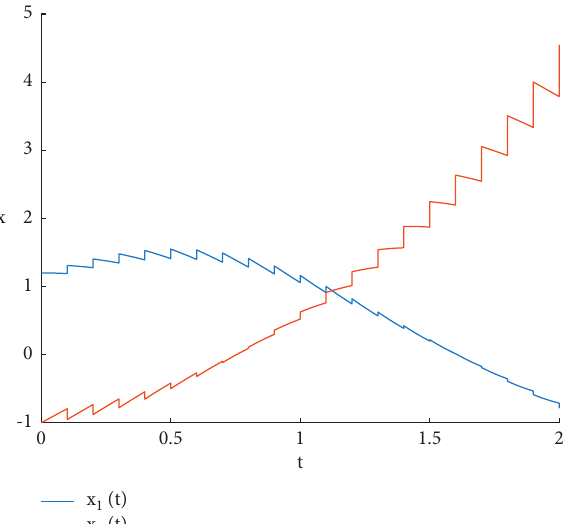
Figure 1: State trajectories x intervals.